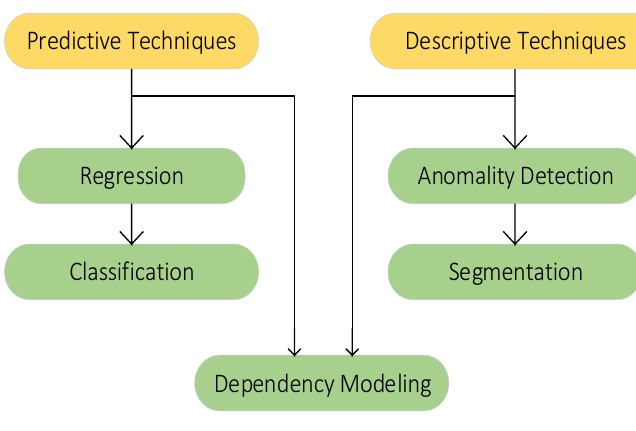
Figure 10. Classification of data mining techniques based on